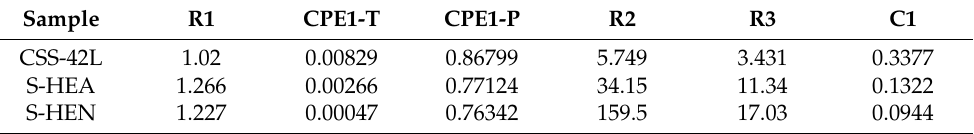
Table 4. The EIS parameters of the CSS-42L and S-HEA/S-HEN in 3.5% NaCl solution.